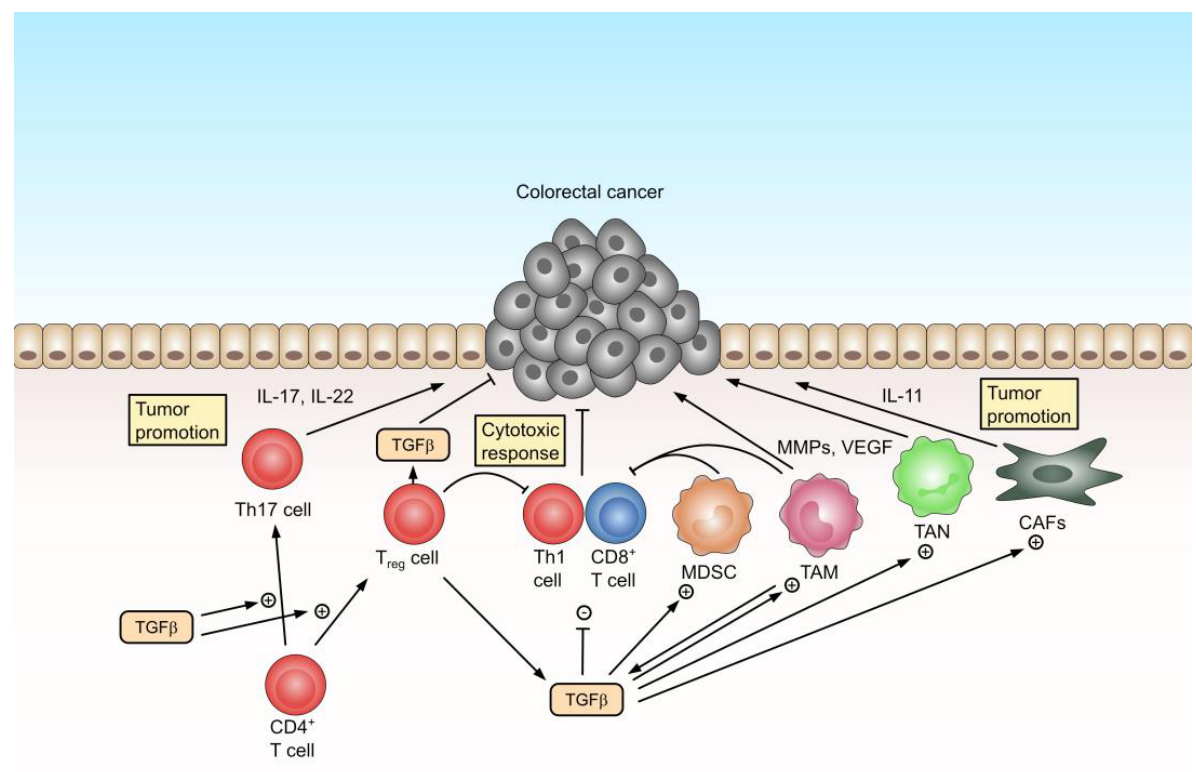
Figure 2. Dual role of TGFβ in the tumor microenvironment of colorectal cancer. TGFβ mediates tumor-promoting effects, e.g., by contributing to a pro-inflammatory environment and suppressing the anti-tumor immune response. Tumor-promoting inflammation is mediated by CAFs or infiltrat- ing TAMs and TANs, which release pro-inflammatory cytokines such as IL-17, IL-22, or IL-11, as well as MMPs and VEGF. TGFβ directly induces Tregs and MDSC to suppress the cytotoxic anti- tumor immune response of Th1 CD4 + T cells and CD8 + T cells. At the same time, TGFβ inhibits ll proliferation and induces the apoptosis of cancer cells. TGFβ = transforming growth factor β; IL-17 = interleukin-17; IL-22 = interleukin-22; IL-11 = interleukin-11; MDSC = myeloid-derived suppressor cells; TAM = tumor-associated macrophage; TAN = tumor-associated neutrophil; CAF = cancer-as- sociated fibroblast; MMP = matrix metalloproteinase; VEGF = vascular endothelial growth factor.